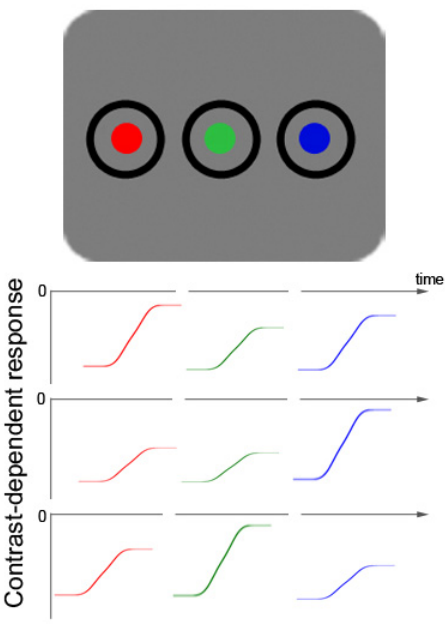
Figure 1. Schematic picture of a color-target display with two additional color distractors (top row). Below that, fictitious color-contrast dependent response functions for three different participants are plotted for all three different hues (rows 2–4). Colors with objectively the same luminance are able to produce different subjectively perceived contrasts in different observers due to varying sensitivity to particular hues. The figure demonstrates how three fictitious participants differ in their sensitivity and have their respective maximal contrast-dependent response in the range of red (row 2), blue (row 3), or green (row 4) colors. This figure illustrates the heterogeneity of the resulting contrast differences between participants, as well as the fact that the contrast differences are relatively small. The small size of the color contrast differences can be inferred from a comparison of the respective sizes of differences of: (1) background luminance responses (at 0) and the asymptotic maximum value of each color-elicited response; and (2) the background and black (this is the starting value of each color-elicited contrast-dependent response function). Figure 1 also depicts the way in which colors of targets and distractors were realized in the current Experiments 4 to 6: as changes from black to red, green, or blue.